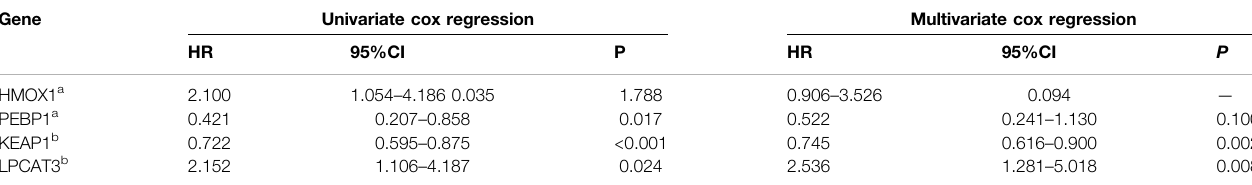
TABLE 2 | cox regression analysis of OS and RFS in breast cancer patients. Gene